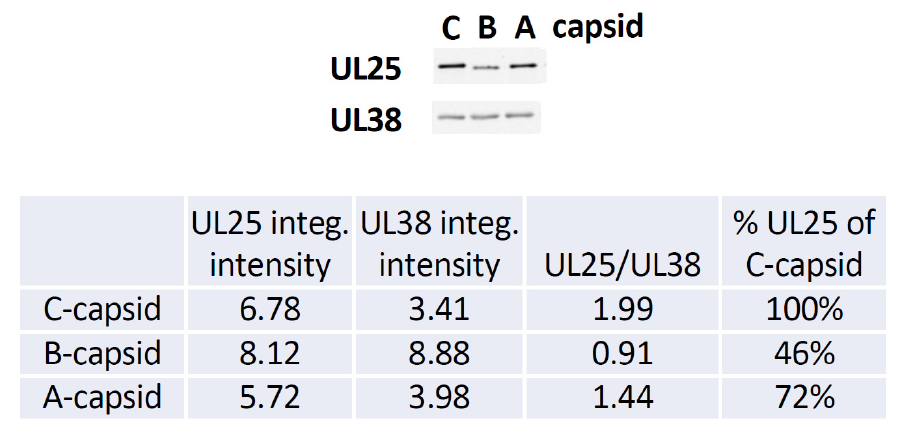
Figure 5. Quantitative western blot analysis of UL25 bound to wild-type (wt) KOS A-, B- and C-capsids. The membrane was probed with mouse anti-UL25, then stripped and reprobed with rabbit anti-UL38 as a measure of the load. The percentage of UL25 bound to each capsid type is shown relative to UL25 bound to wt C-capsid was (calculated through the normalized ratios of UL25 (63 kDa) intensity to UL38 (50 kDa) intensity on the blot. Data courtesy: Jamie B. Huffman, University of Pittsburgh.